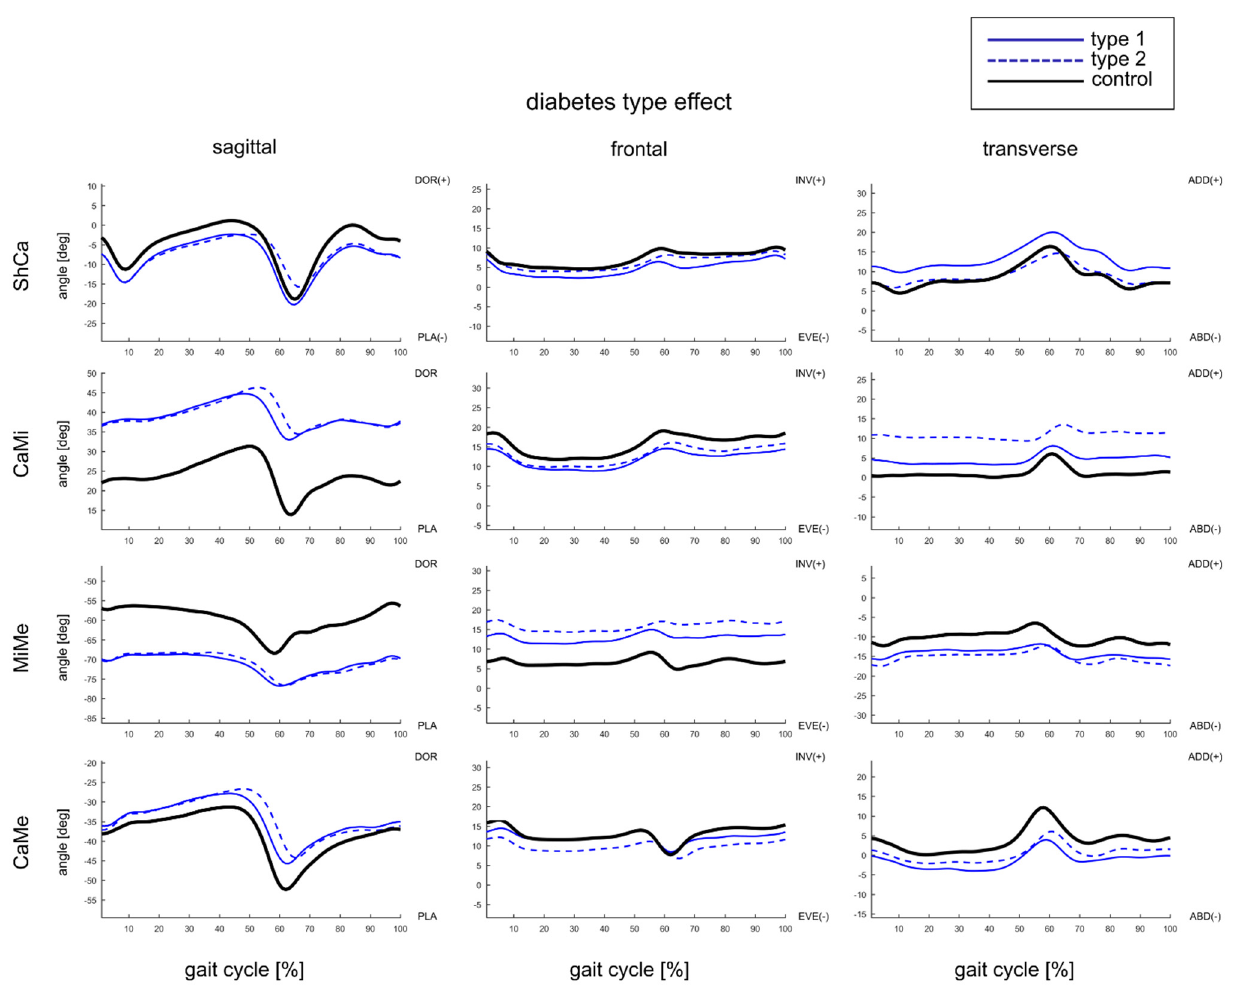
Figure 2. Mean temporal profiles of foot joint rotations [deg] normalized to gait cycle duration across all trials of type 1 (continuous blue line) and type 2 diabetes (dashed blue line), and control subjects (continuous black line). Top to bottom, rotation in the three anatomical planes between calcaneus and shank (ShCa), midfoot and calcaneus (CaMi), metatarsus and midfoot (MiMe), and metatarsus and calcaneus (CaMe). Left to right, rotations in the sagittal, frontal and transverse planes according to the axes of each joint coordinate system.